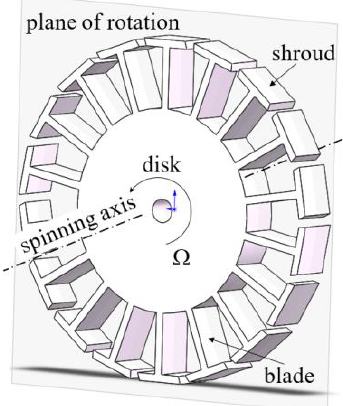
Figure 1. Sketch of a rotating shrouded blisk.